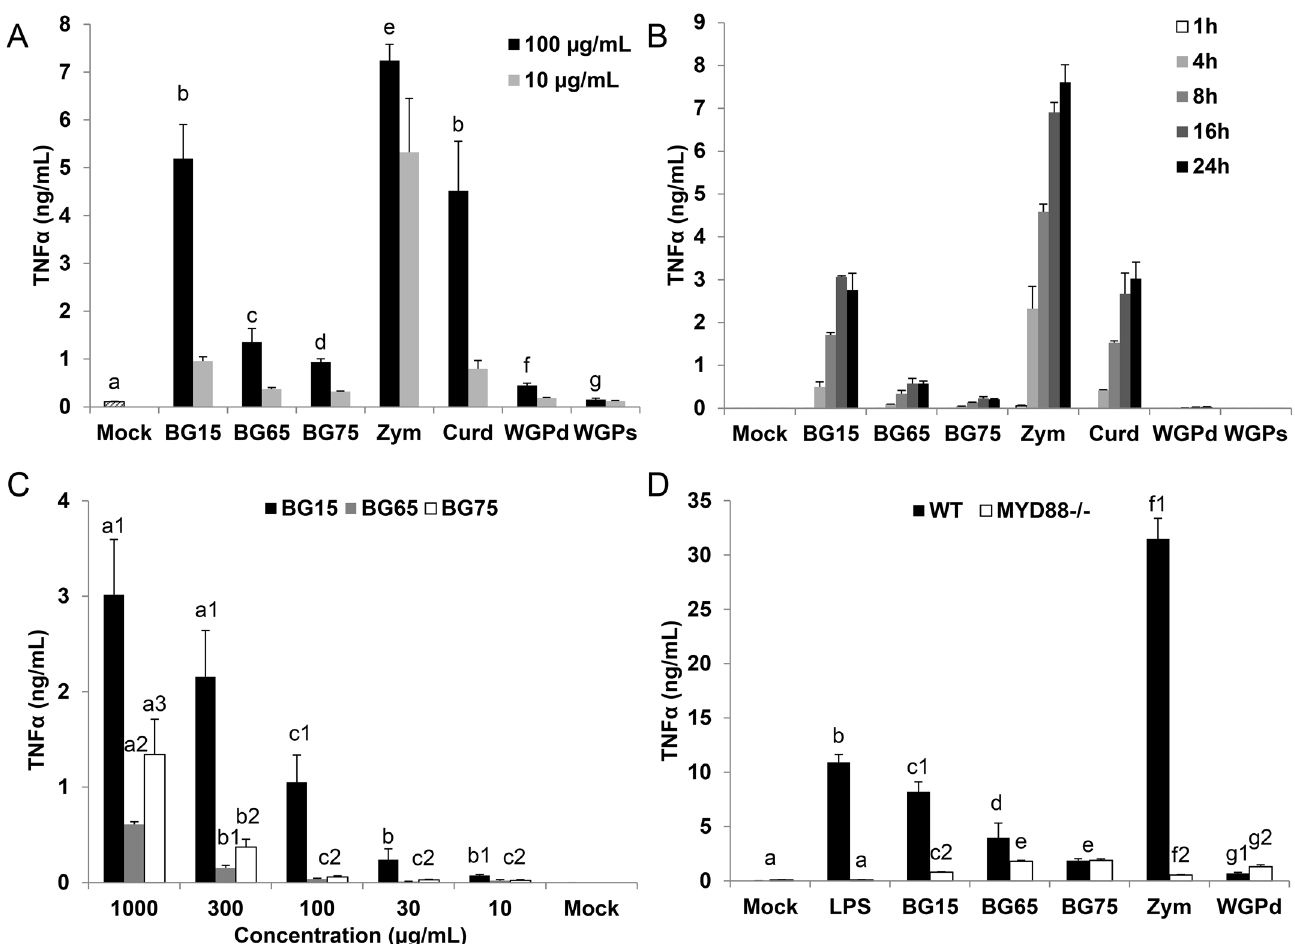
Fig 3. Murine macrophages treated with extracts enriched in BG produce less TNF α than those treated with unpurified Sc cell wall extracts. (A) RAW-Blue ™ macrophages were treated with 100 or 10 μ g/mL of Sc BG extracts (BG15, BG65 and BG75) or control (zymosan, curdlan, dispersible WGPd and soluble WGPs) for 16 h and TNF α was then quantified by ELISA. Comparisons are shown for BG compounds used at 100 μ g/mL. (B-C) BMDM from C57Bl/6 mice were subcultured in 96-well plates. (B) Cells were stimulated for 1, 4, 8, 16 or 24 h with 100 μ g/mL of Sc BG extracts (BG15, BG65 and